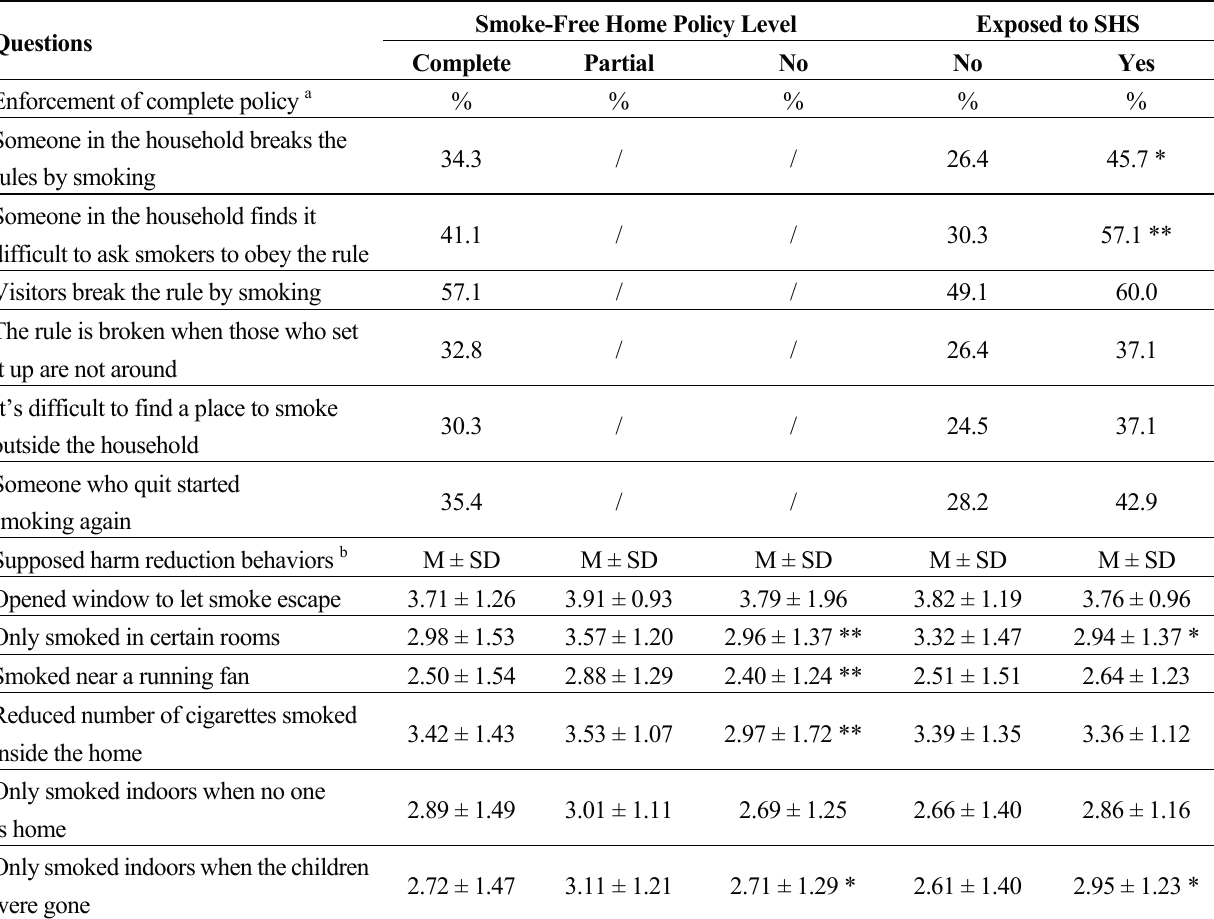
Table 2. Enforcement, supposed harm reduction behaviors, and self-efficacy of maintaining policy related to smoking in the home in relation to level of smoke-free home policy, and exposure to SHS in the home in the past 7